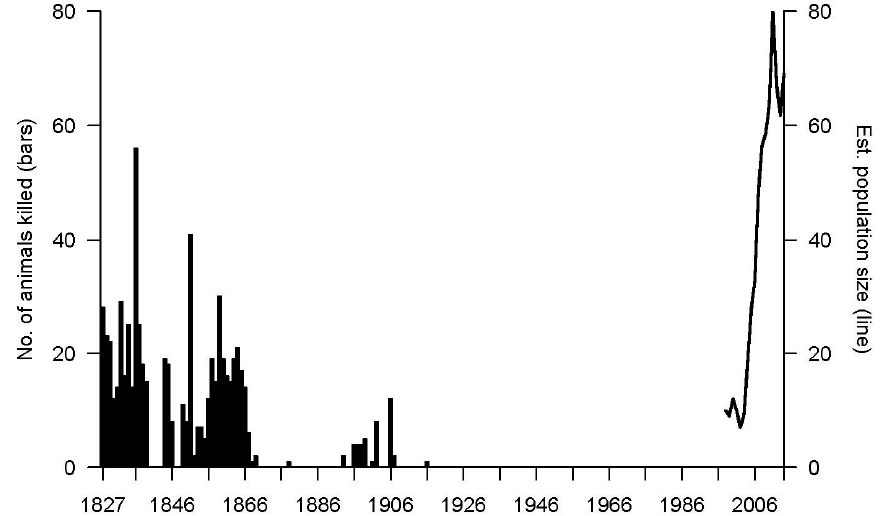
Figure 4. Number of wolves killed 1827–1965 (no data available for 1840–1843 and 1847–1848) in Jämtland (bars). Wolf population size based on yearly winter counts 1998/1999–2014/2015 in Jämtland (line). Sources: Swedish National Forest Service and Wildlife Damage Centre. Please note that the bounty data end in 1965 and winter counts start in the winter1998/1999.